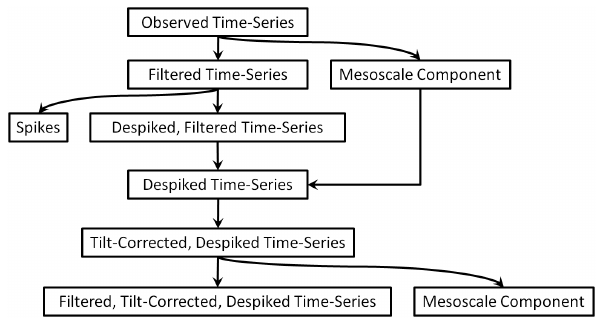
Fig. 2. Flow chart of the quality control and preprocessing